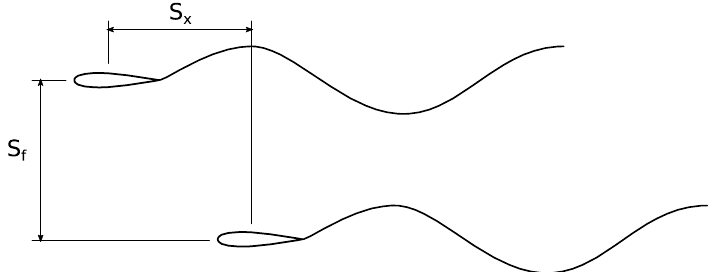
Figure 14. Staggered twin-foil configuration. S f is the vertical mean foil distance and S X is the horizontal foil distance.